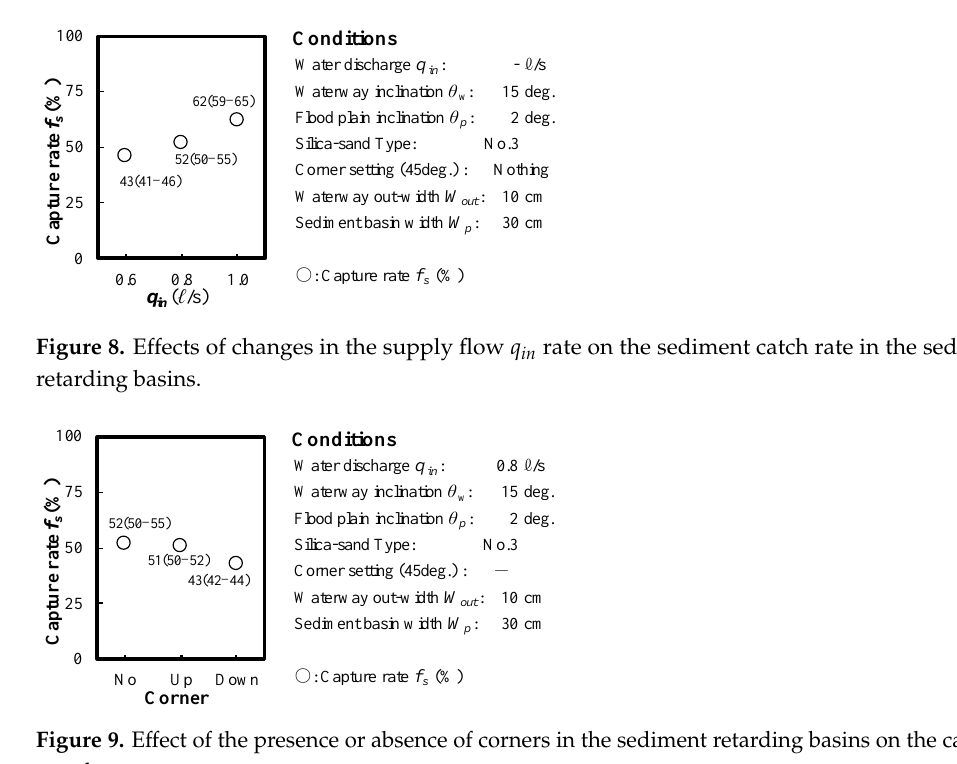
Figure 9. Effect of the presence or absence of corners in the sediment retarding basins on the capture rate f s .